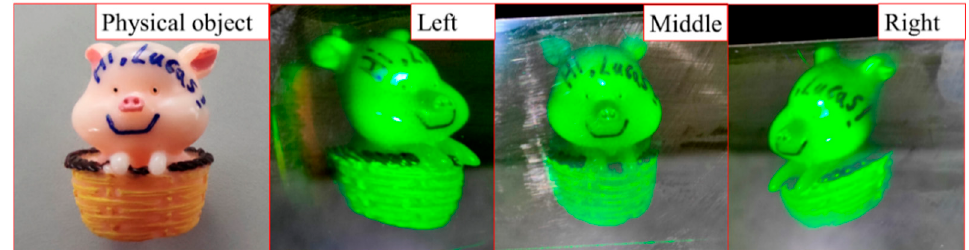
Figure 7. Volume holography reproduces monochromatic 3D objects under white light.